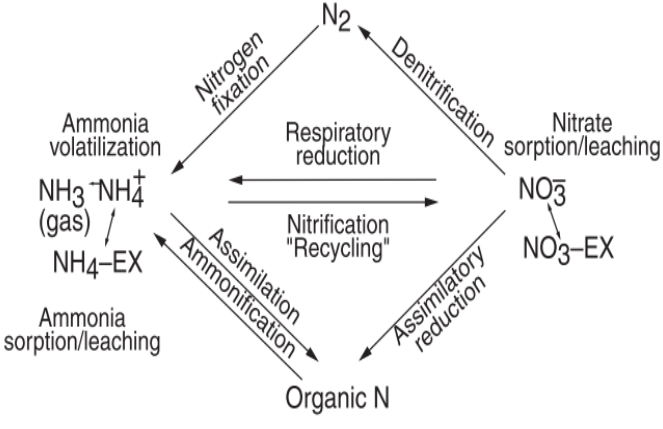
Figure 2. Biochemical cycles of nitrogen